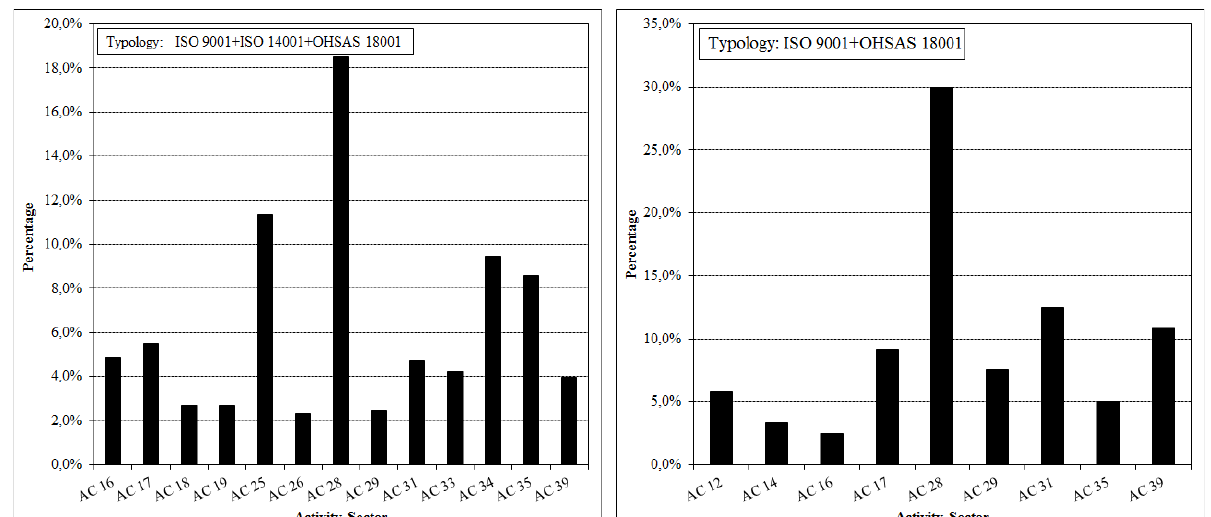
Figure 11. Integrated Typology ISO 9001+ISO 14001+OHSAS 18001: Breakdown by activity sectors.